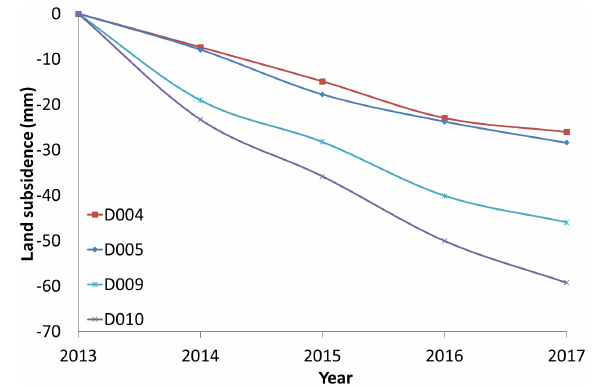
Figure 2. Land subsidence curves (D004 and D005 dredger fill formed earlier, D009 and D010 formed